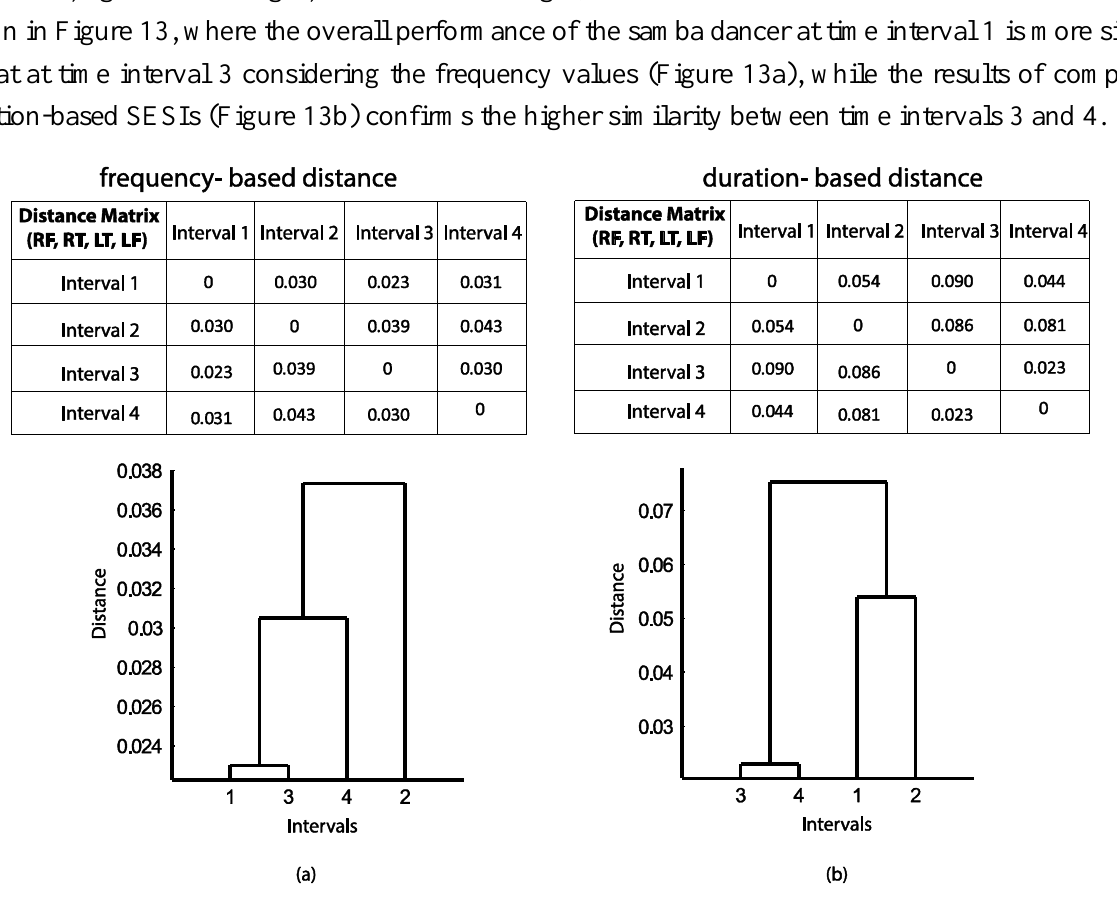
Figure 13. Distance between hyper-SESIs at four time intervals of movement both for ( a ) frequency and ( b ) duration alongside the dendrograms that represent the agglomerative hierarchical clustering of pairs of